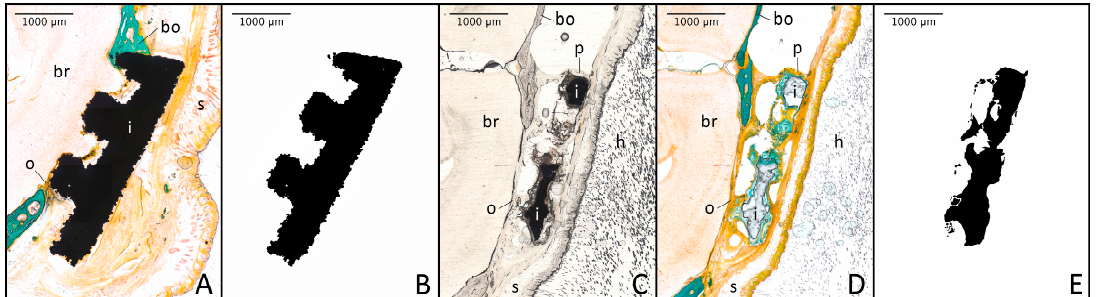
Figure 5. Laterolateral thin section of a mouse treated with an uncoated titanium implant ( A ) or an PCL-coated magnesium implant ( C , D ) before ( C ) or after trichrome-masson-goldner staining (( A , D ); bo = mineralised bone tissue, br = brain, h = hair, i = implant in the defect, o = osteoid, p = PCL, s = skin; 10-fold magnification); thresholded uncoated titanium implant ( B ) or manually reconstructed PCL-coated magnesium implant ( E ) ready for analysis.